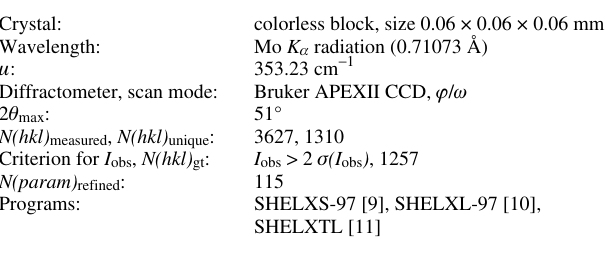
Table 1. Data collection and handling.